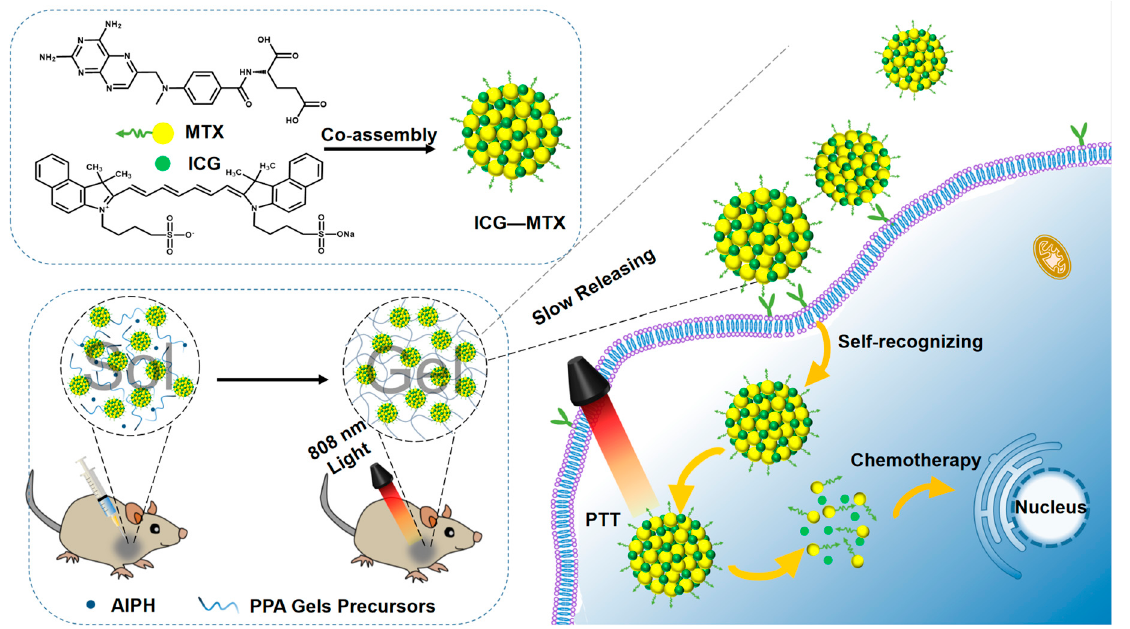
Figure 1. The preparation of ICG—MTX and ICG—MTX@PPA Gels and their application in tumors